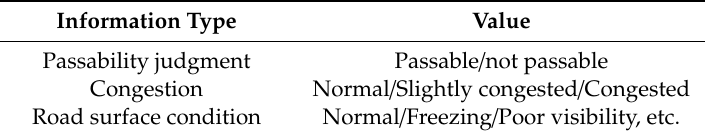
Table 2. Types of road and tra ffi c